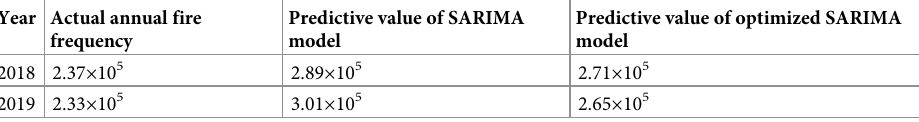
Table 2. Comparison of predicted value and actual value of SARIMA model and optimization